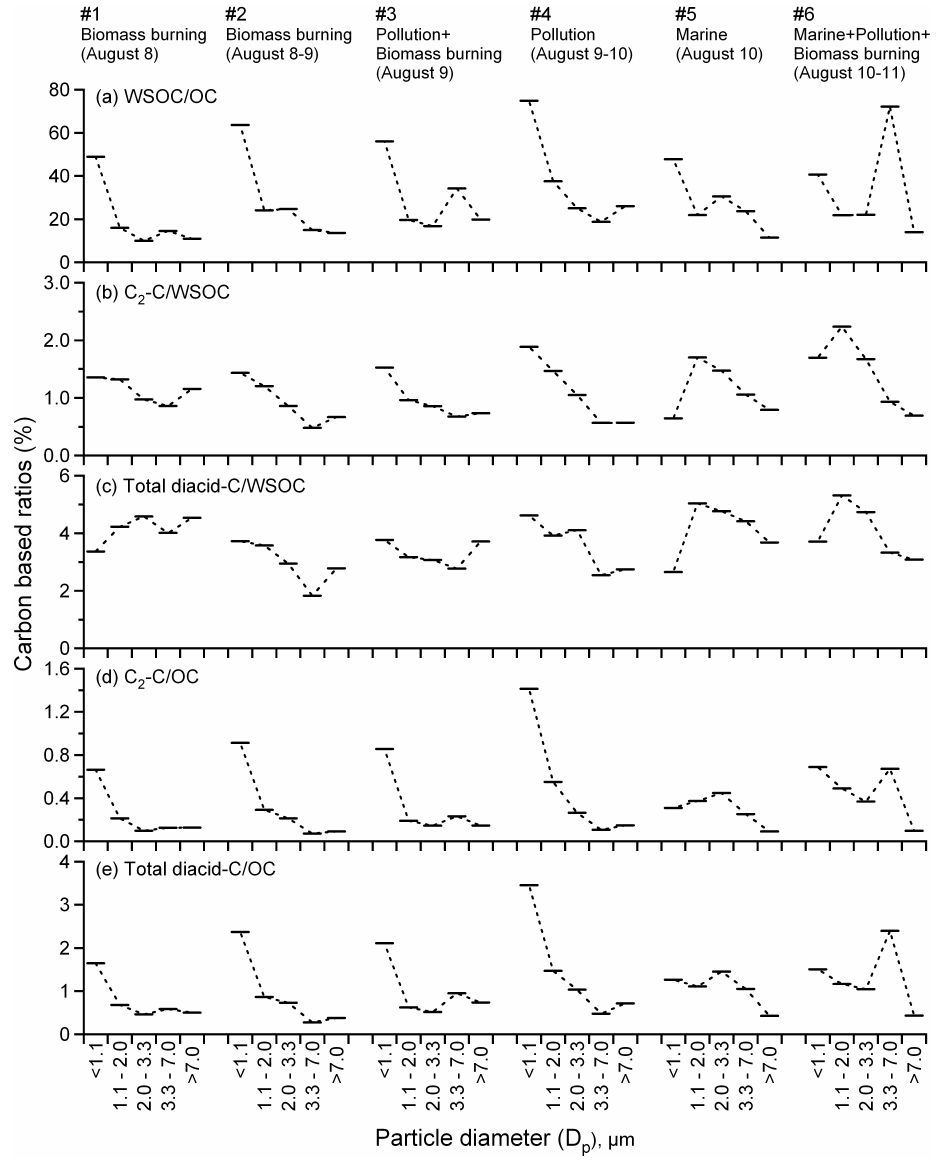
Fig. 10. Size-segregated ratios of (a) WSOC/OC, (b) oxalic acid-C/WSOC, (c) total diacid-C/WSOC, (d) oxalic acid-C/OC and (e) total diacid-C/OC in the aerosol samples collected during the campaign from 8–11 August 2005 in Sapporo, northern